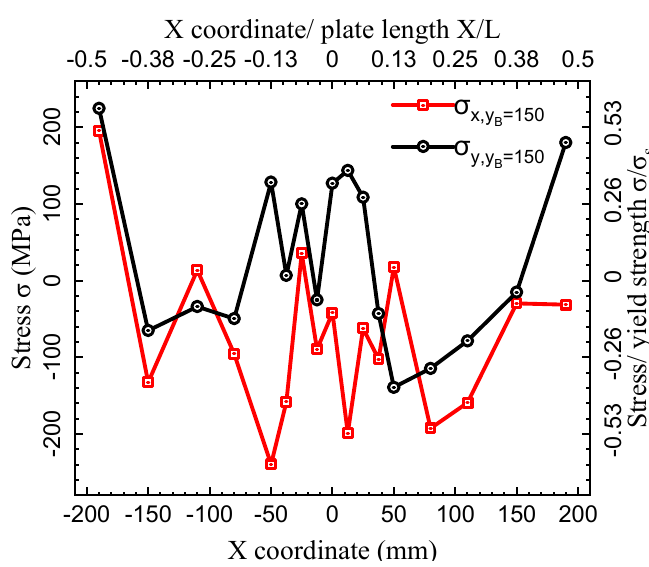
Figure 12. The stress on path L yA = 150 .